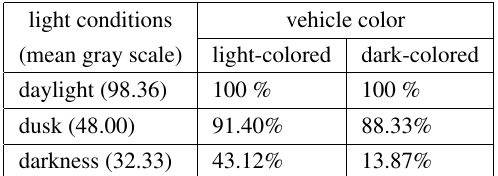
Table 1. Vehicle detection accuracy under different light